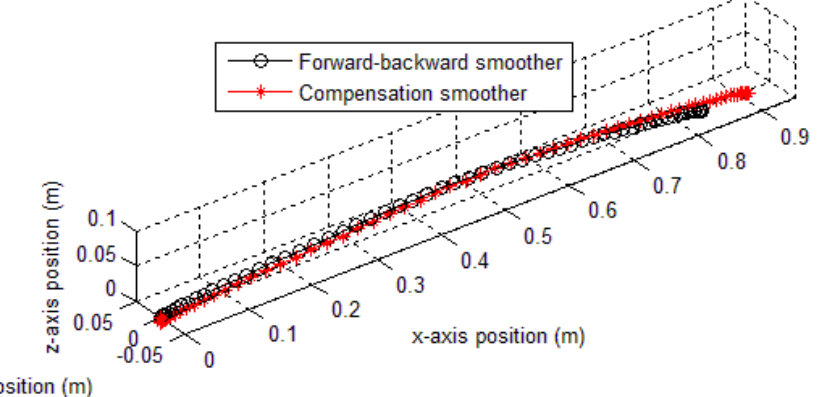
Figure 13. Trajectories of 0.95 m straight movement experiment (method 1 result).